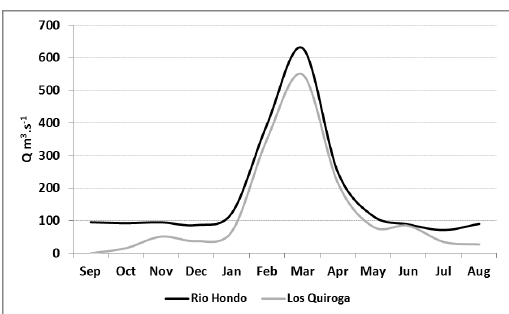
Figure 2. Hydrogram corresponding to the period 2014/2015 based on average monthly flows in the Río Hondo dam and the estimated downstream of the weir at Los Quiroga town.